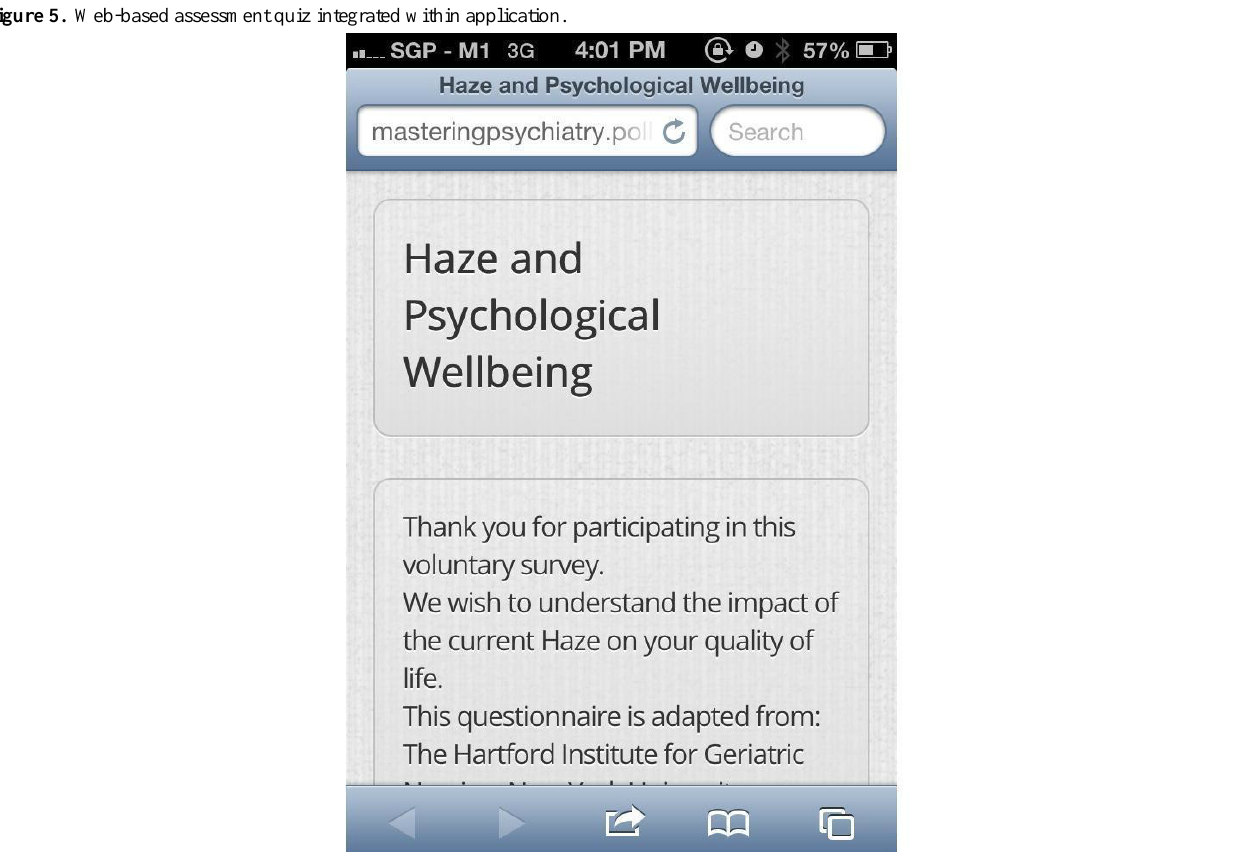
Figure 5. Web-based assessment quiz integrated within